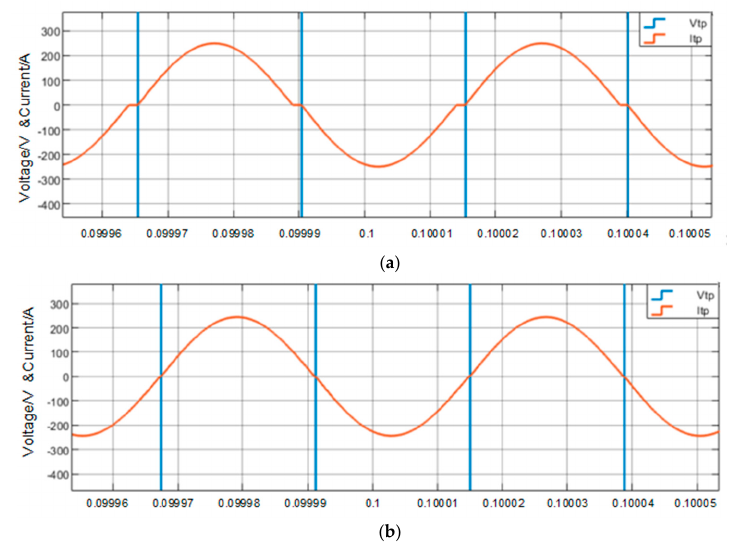
Figure 10. Voltage and current waveforms of the primary side of the DCX transformer ( a ) before the DCX reaches the resonant condition and ( b ) after the DCX reaches the resonant condition.